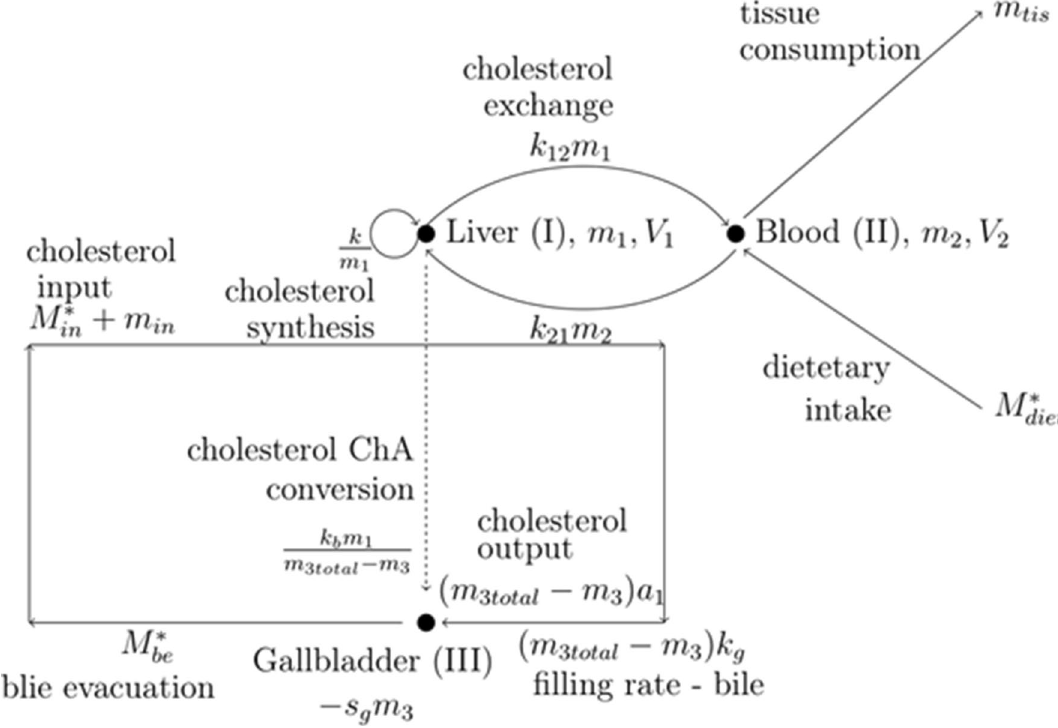
Figure 2. Schematic representation of the three-compartment model of cholesterol homeostasis in the human body. The three compartments refer to the following: m 1 , V 1 —the mass of cholesterol in the volume of blood plasma in the liver (I); m 2 , V 2 —the mass of cholesterol in the volume of peripheral blood plasma (II); and m 3 , V 3 —the mass of ChA in the volume of the gall bladder (III). Dashed line represents the conversion of cholesterol into ChA (one cholesterol molecule is converted into one ChA molecule). Therefore, k b m 1 /( m 3total − m 3 ) represents the outflow of cholesterol from compartment I and the entry of ChA into compartment